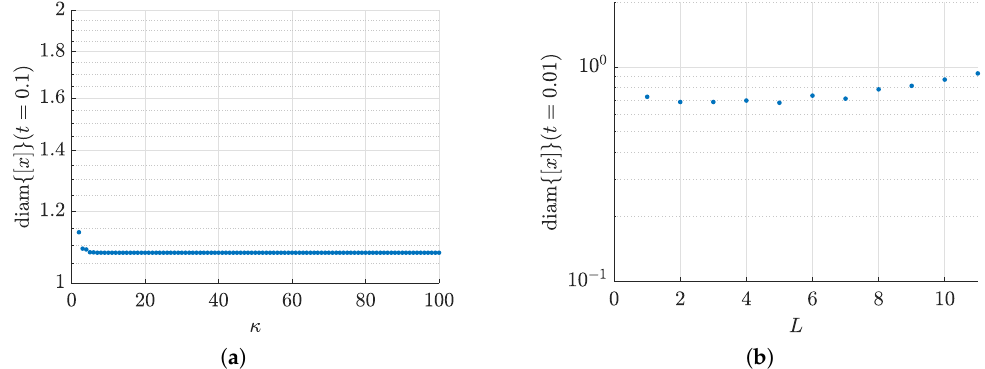
Figure 6. Dependence of the solutions according to Theorems 4 and 5 on the iteration numbers and series expansion orders in example (40) with (41): ( a ) Multi time step Picard iteration; ( b ) Temporal series